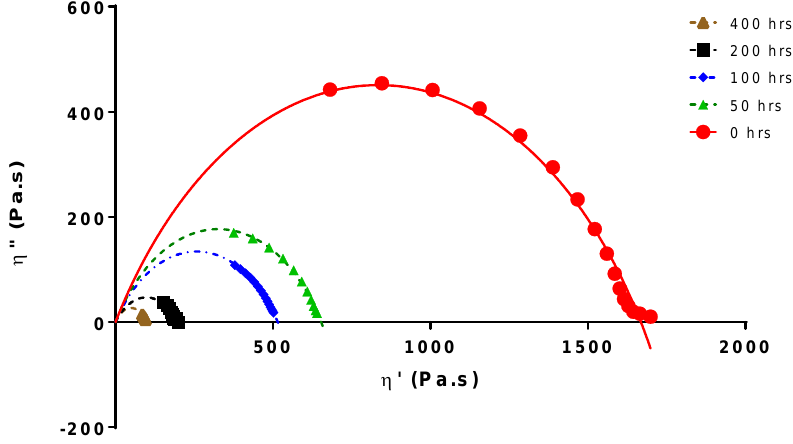
Figure 1. Cole–Cole plot of aged and non-aged PLA4042D.